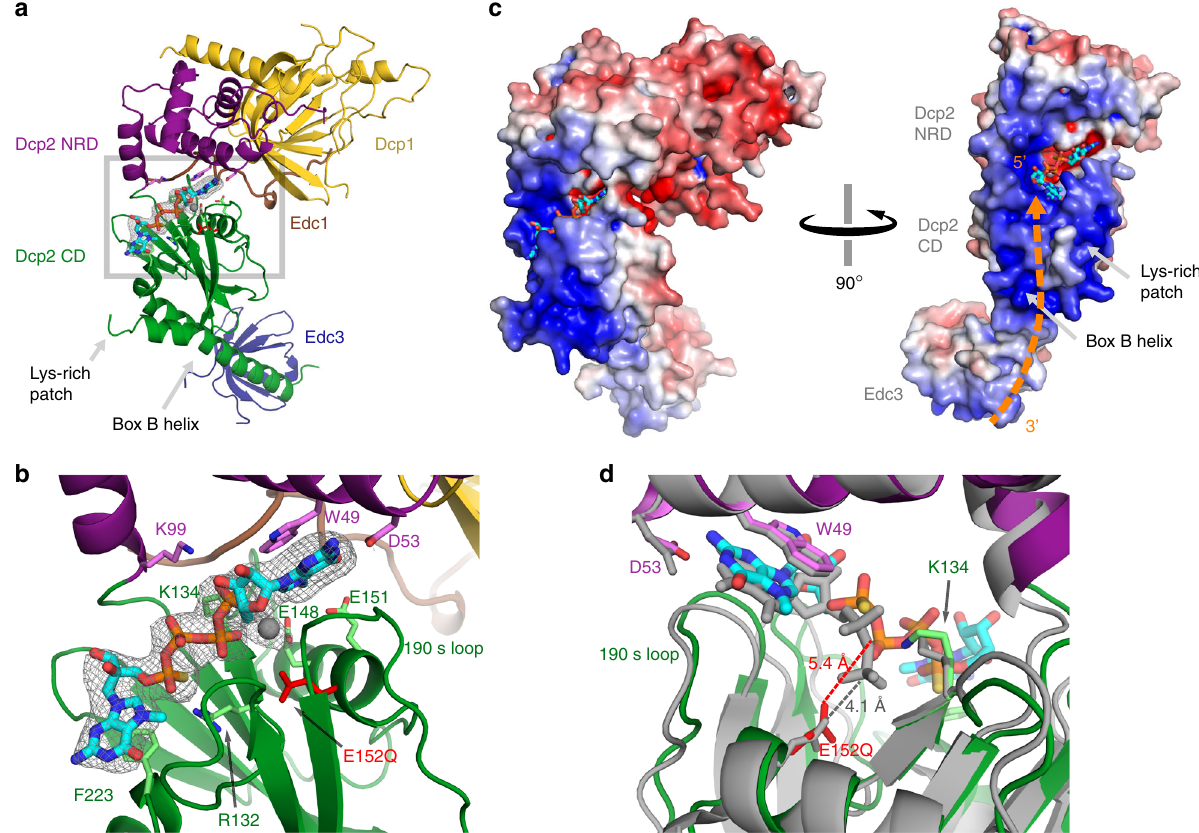
Fig. 3 Substrate analog binding to the active conformation of Edc1 – Dcp1 – Dcp2 – Edc3 decapping complex. a Full Edc1 – Dcp1 – Dcp2 – Edc3 structure showing substrate analog binding between the Dcp2 NRD and CD. b Close-up of substrate analog bound at the Dcp2 active site. Conserved, catalytically important residues that contact the cap analog are shown as sticks. The catalytic Glu base (mutated to Gln in our structure) is colored red; Mg 2 + ion is shown as a gray sphere; F o – F c omit map for cap analog and Mg 2 + is shown at 2.5 σ in gray. c Edc1 – Dcp1 – Dcp2 – Edc3 complex with calculated electrostatic surface ( − 6 to + 6 kT/e) in the same orientation as in ( a ) (left), and rotated 90° (right). Dotted orange line shows the predicted path of RNA based on the orientation of substrate analog in the active site of Dcp2. The 5 ′ cap of RNA binds in the Dcp2 composite active site (substrate analog in cyan), RNA follows the positively charged Dcp2 CD C-terminal Box B helix past a conserved Lys-rich patch, to Edc3 coactivator. d Alignment of the substrate analog-bound (colored structure, PDB 6AM0) and product-bound (gray, PDB 5LOP 22 ) K . lactis Dcp2 structures; view is rotated 180° from that shown in ( a ) and ( b ). The Dcp2 NRD (residues 8 – 97) was used for alignment, giving a backbone RMSD of 0.78 Å; all-atom RMSD for alignment of both the NRD and CD (residues 8 – 240) of substrate analog versus product-bound Dcp2 is 1.6 Å. Distance from catalytic Glu residue to β -phosphate of substrate analog or product are shown as red and gray dotted lines,